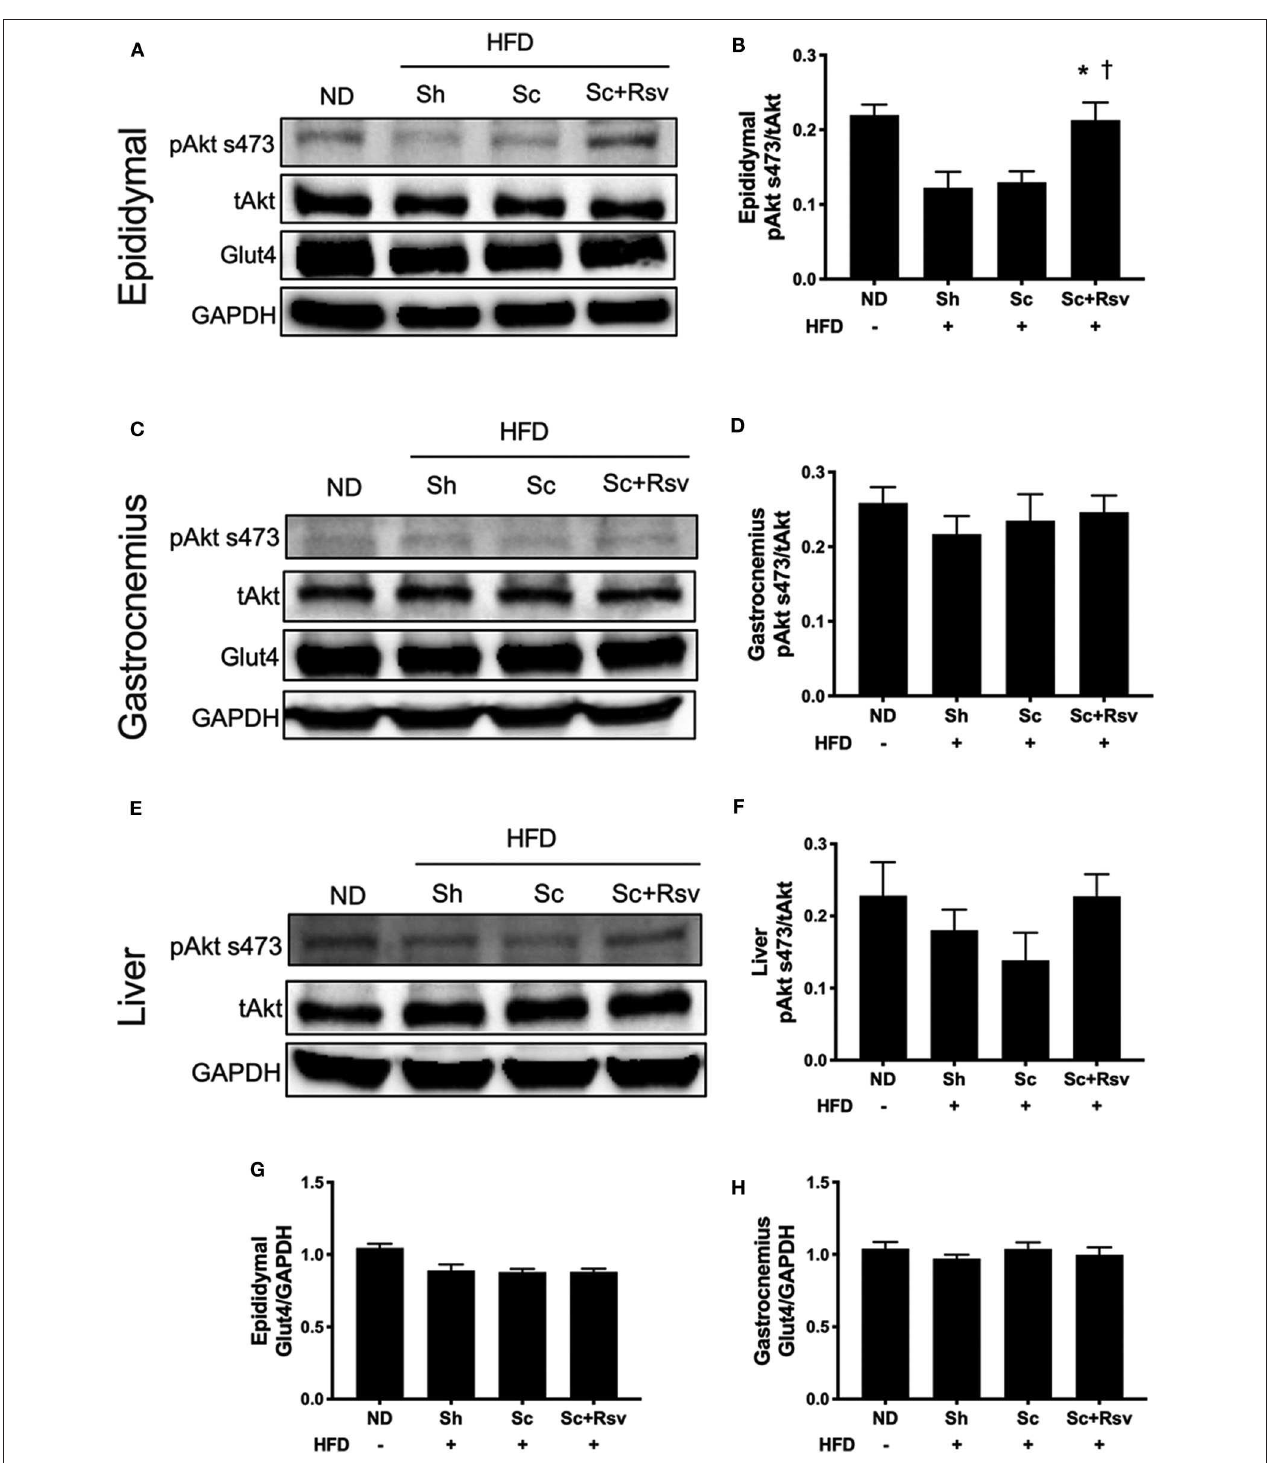
FIGURE 5 | Impact of scaffolds on proteins associated with insulin signaling and glucose uptake in the epididymal fat pad, gastrocnemius muscle, and liver. (A,C,E) Representative western blots and (B,D,F) band quantification of Akt ratio for the epididymal fat pad (A,B) , gastrocnemius (C,D) and liver (E,F) . (G,H) Glut4 expression normalized to GPADH is depicted for the epididymal fat pad (G) and the gastrocnemius (H) . Statistics were calculated by one-way ANOVA with Tukey’s multiple comparisons test. * Represents p < 0.05 compared to HFD + Sh, † represents p < 0.05 compared to HFD + Sc. n = 5 mice per group.